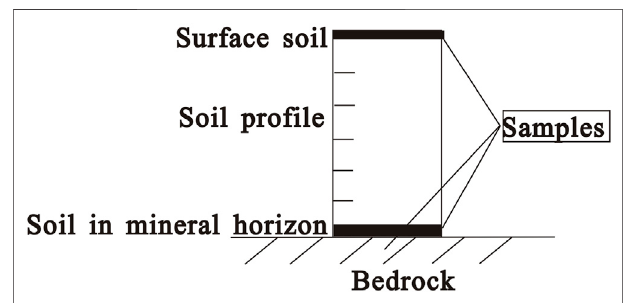
FIGURE 2 | Sketch map of soil sampling for every bedrock